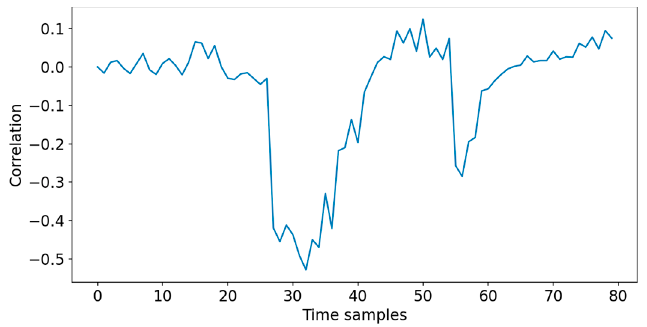
Figure 8. Enlarged result of corresponding interest interval.